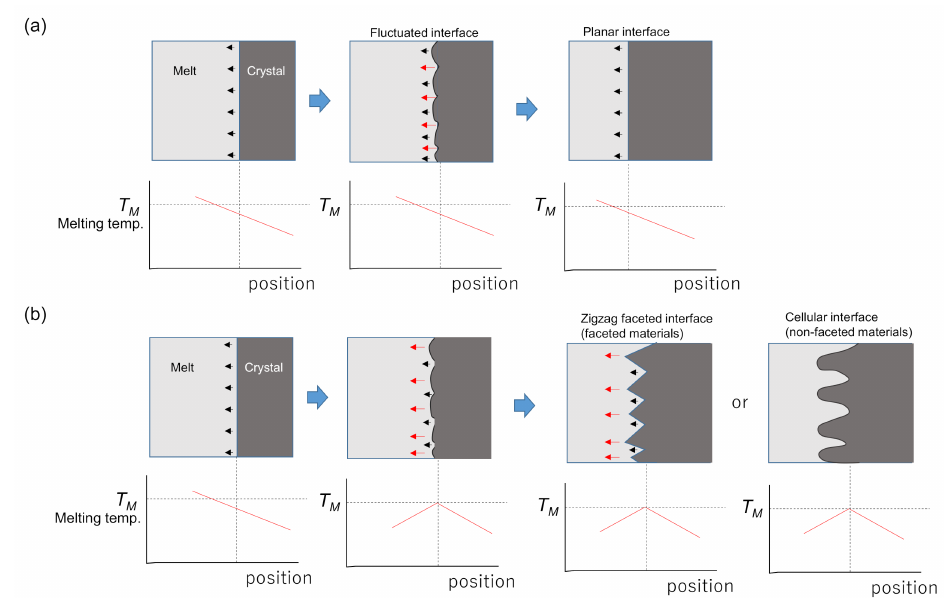
Figure 5. Schematic illustration of the shape transformation of crystal/melt interfaces. ( a ) A planar interface is maintained due to a positive temperature gradient in the melt at the interface, and ( b ) a zigzag faceted or cellular interface is formed due to a negative temperature